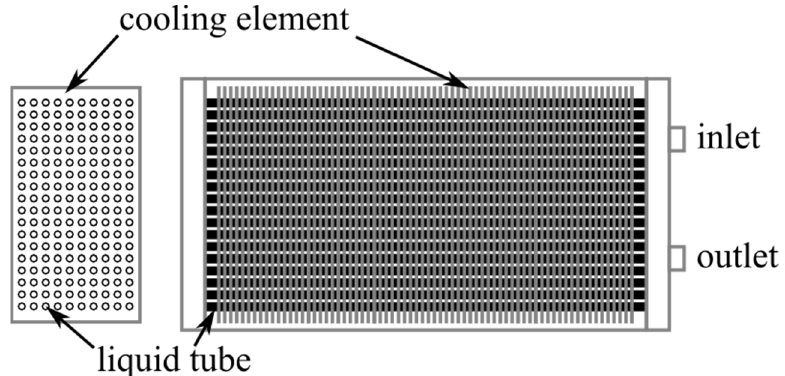
Figure 26. External heat exchanger